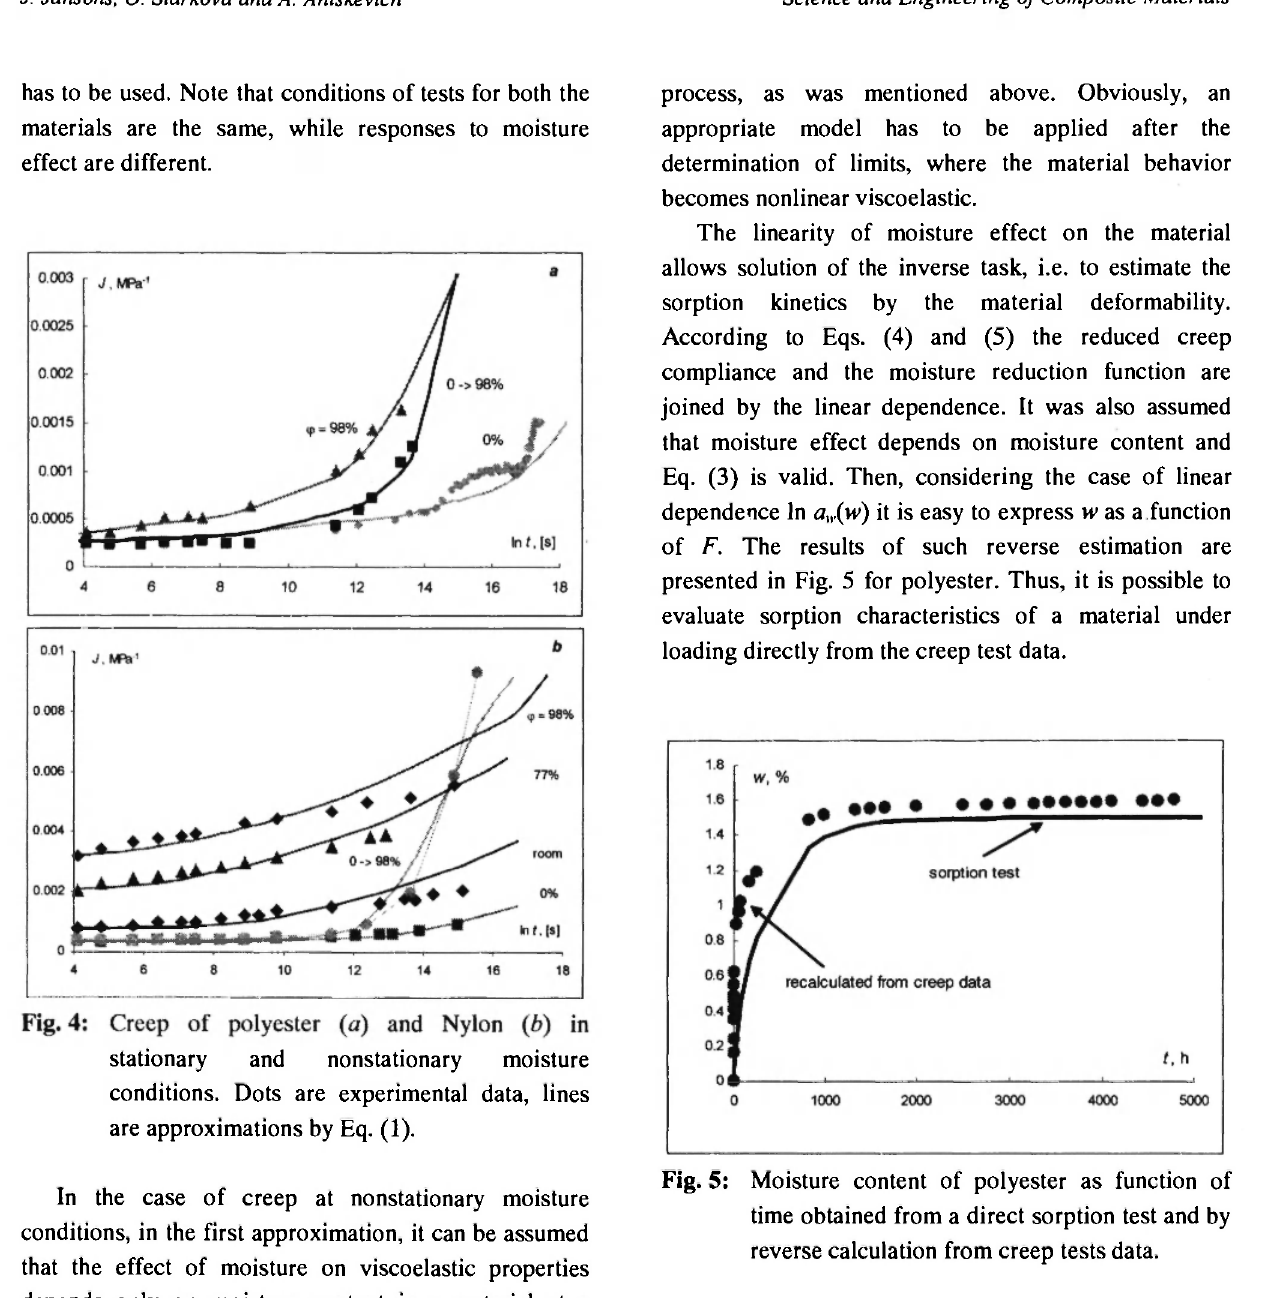
Moisture content of polyester as function of time obtained from a direct sorption test and by reverse calculation from creep tests